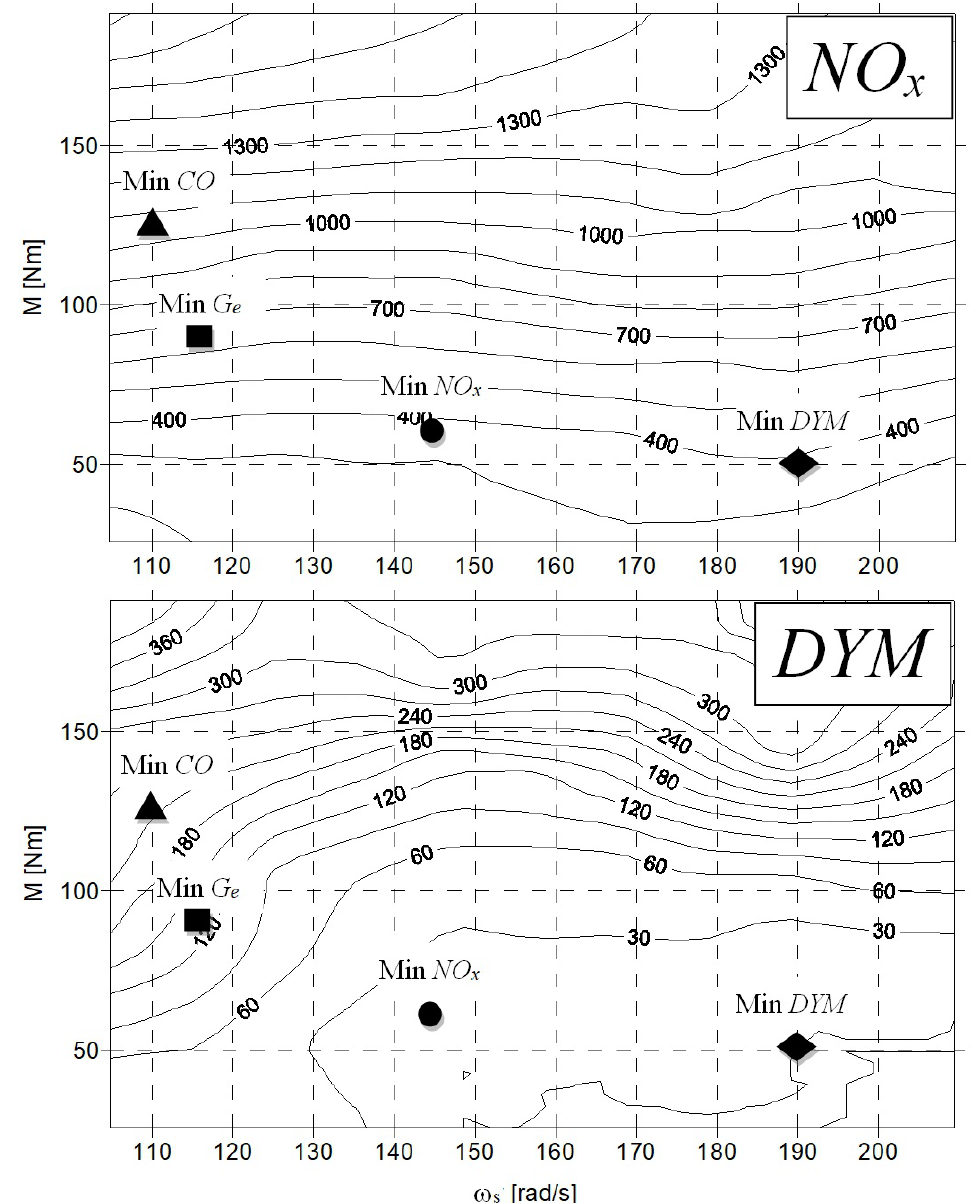
Figure 16. Universal characteristics and optimal points according to particular criteria for load I ( NO x , DYM